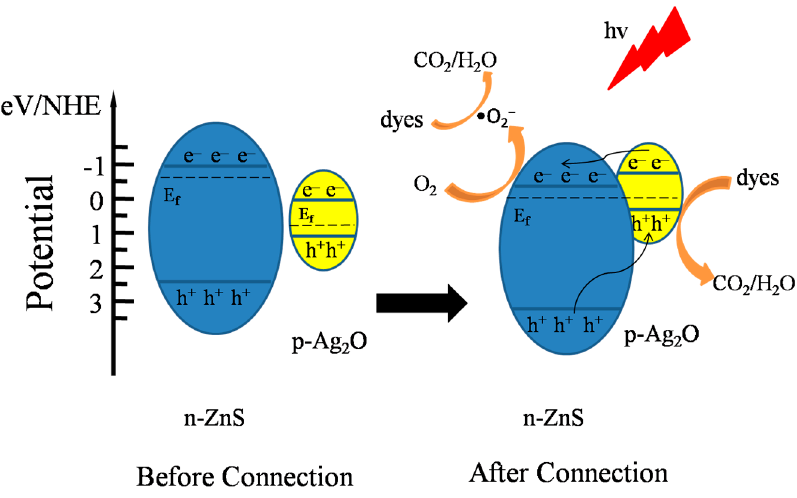
Figure 10. Mechanism for the enhanced photocatalytic activity of the ZnS/Ag 2 O composite.